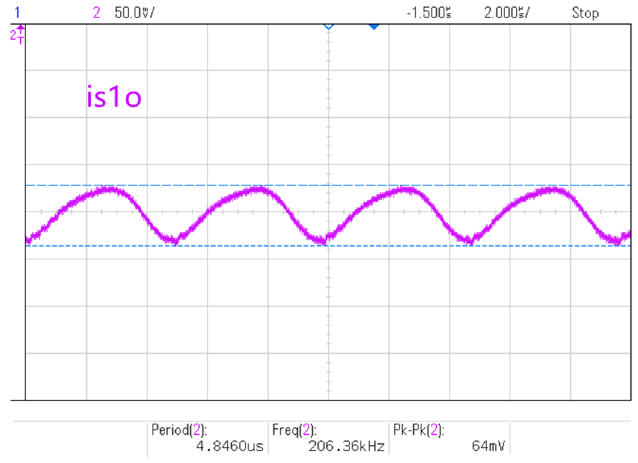
Figure 30. Input current wave form under load condition of IDC .